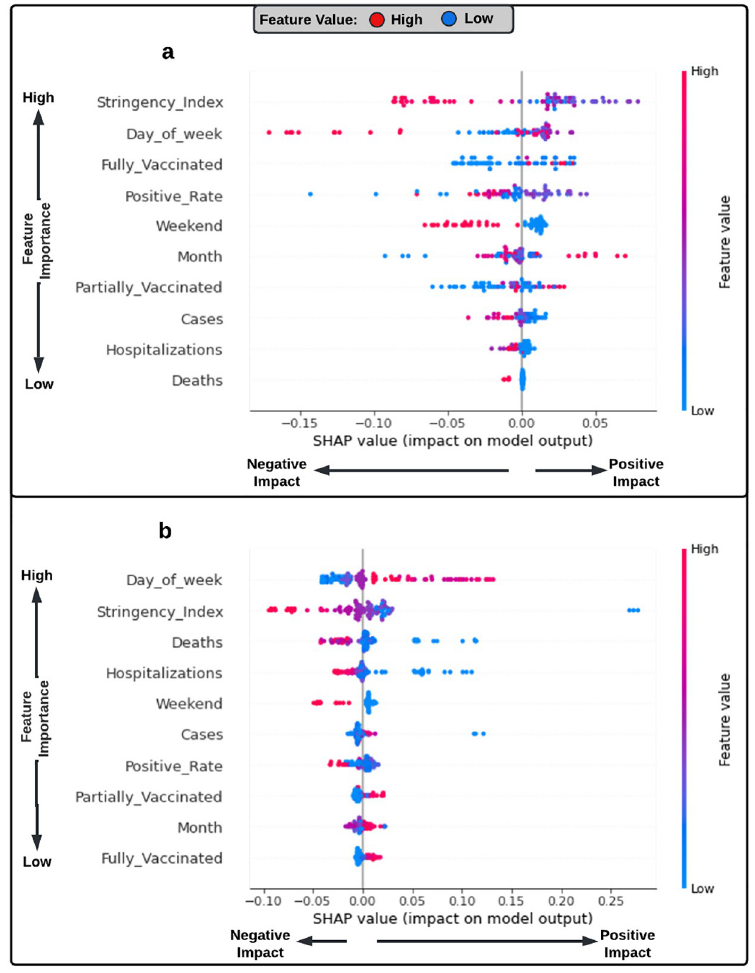
Fig 5. SHAP summary plot for the percent reduction in the daily demand models. (a) Innisfil model. (b) Chicago model. Each point in the summary plot represents a Shapley value for a feature and an instance. The feature importance determines its position on the y-axis, the Shapley value determines its position on the x-axis, and the value determines its colour.